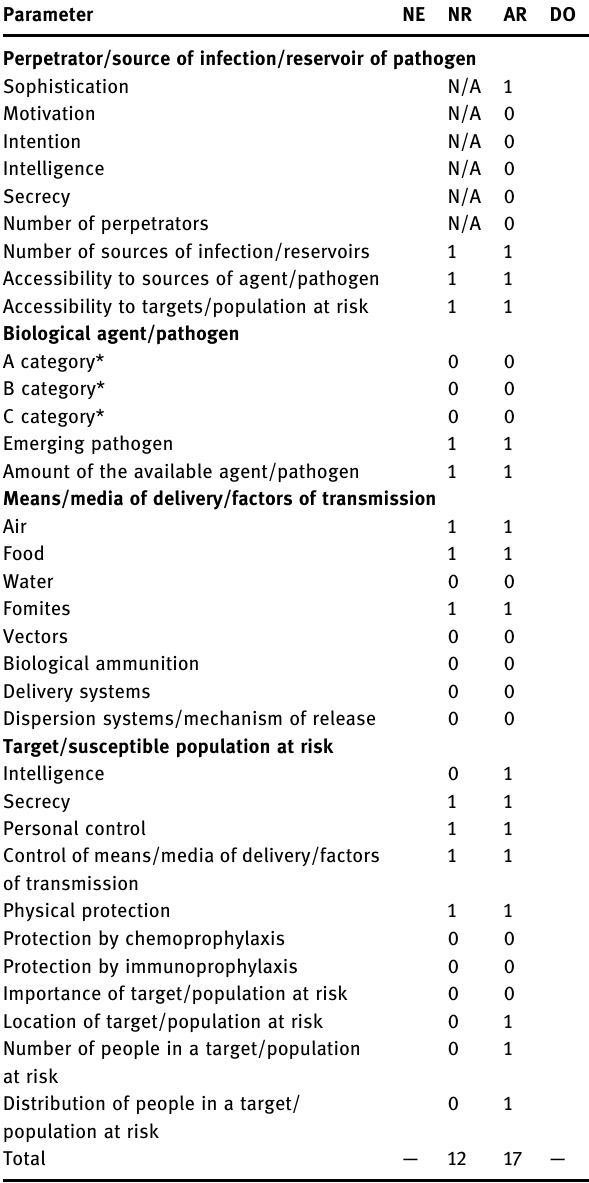
Table 2: Assessment of the COVID - 19 pandemic origin in 2019 – 2020 by di ff erentiation scoring for a natural outbreak of a disease ( NE ) , a natural outbreak of a new or re - emerging disease ( NR ) , an outbreak by an accidental release of a pathogen ( AR ) ,